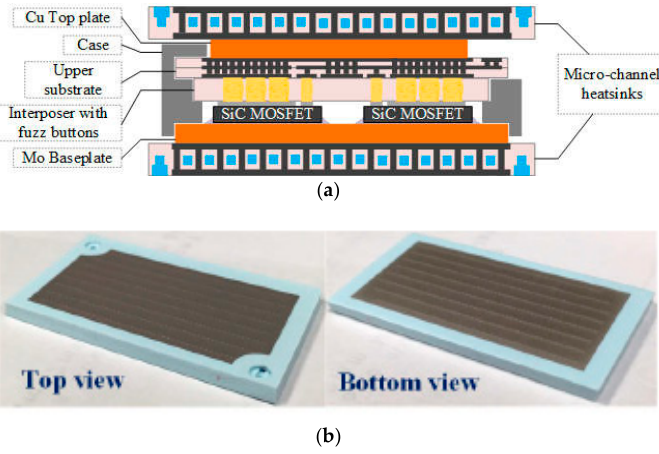
Figure 14. 3D stacked power module with a fuzz button embedded interposer by Zhu et al. [69]. ( a ) A schematic showing the cross section of the module; and ( b ) photographs showing the top and bottom views of the low temperature co-fired ceramic (LTCC) microchannel heat